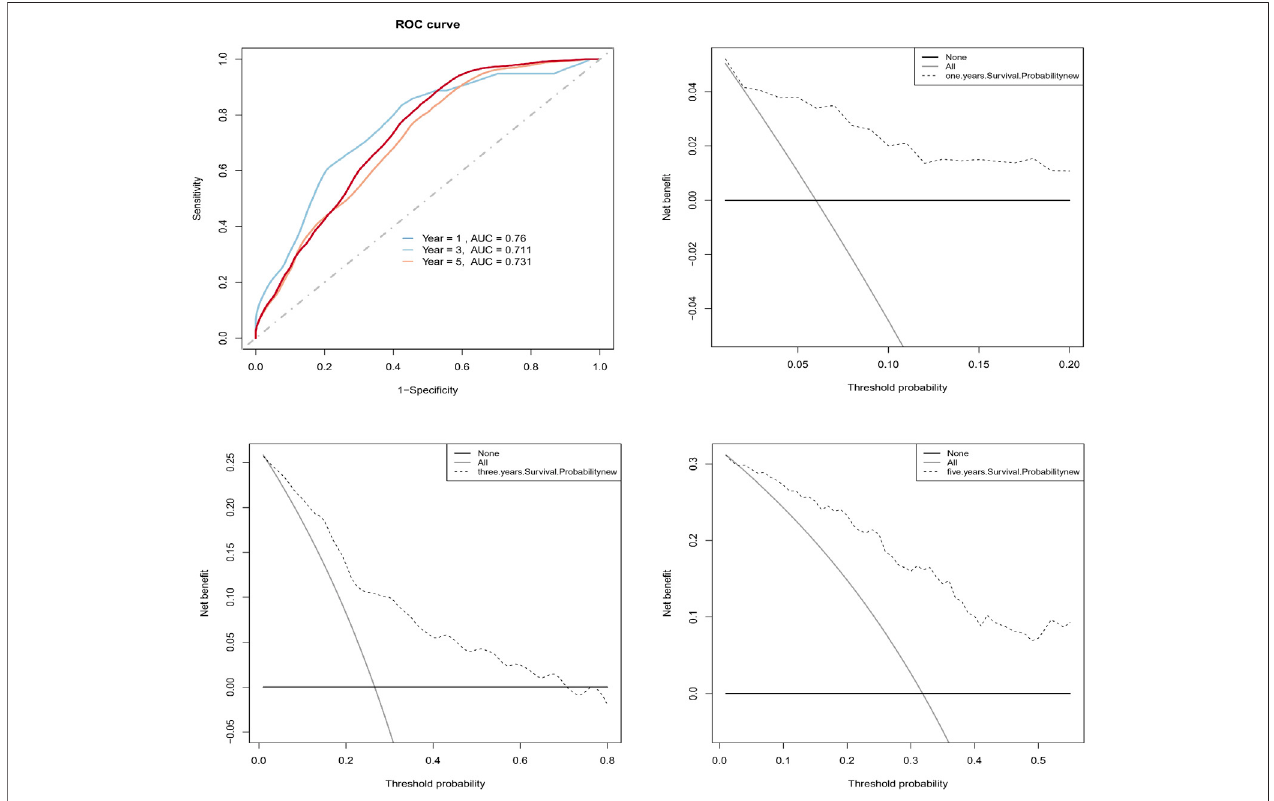
FIGURE 4 | Evaluation of the predictive prognosis capability of CC by hub signatures. (A) The 1-, 3-, 5-year AUC of ROC curve was 0.760, 0.711, and 0.731, indicating better predictive power; (B, C, D) The decision curve analysis (DCA) estimated the accuracy of predicting 1-, 3-, 5-year prognosis.